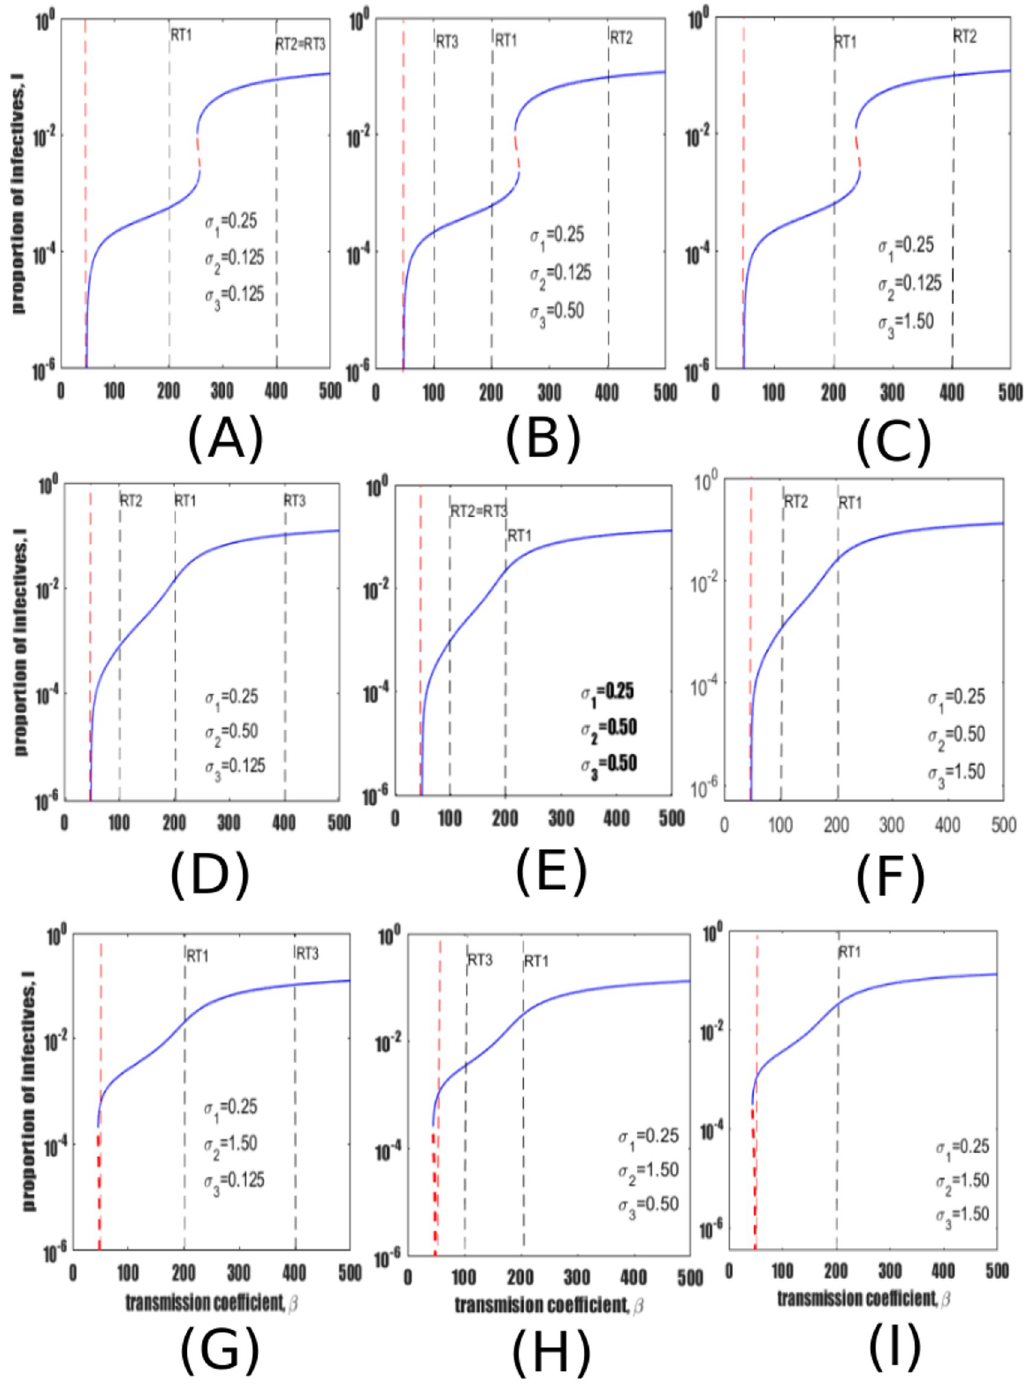
Fig 4. Exploration of the full range of plausible values of the relative risk of reinfection parameters. All panels show equilibrium prevalence as a function of the transmission coefficient β . From left to right, each column shows an increase in the relative risk of reinfection among recovered individuals σ 3 , while from top to bottom each row shows increasing risk of reinfection among individuals treated with IPT σ 2 . Other parameter values remain at baseline values in Table 1. σ i values are presented such that individuals previously treated for LTBI or for active disease may have 1) lesser susceptibility than that estimated for LTBI ( σ 2 , σ 3 < σ 1 ), 2) intermediate susceptibility between LTBI and full susceptibility ( σ 2 or σ 3 > σ 1 , but < 1) or 3) greater susceptibility than full susceptible persons ( σ 2 or σ 3 > 1). The red dotted vertical line marks the point at which R 0 = 1. The dotted red segment of the endemic curves represents the unstable equilibria while the blue line represents stable equilibria.